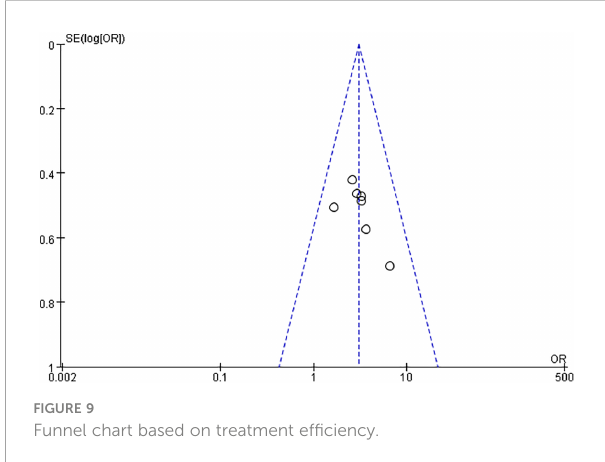
FIGURE 9 Funnel chart based on treatment ef fi